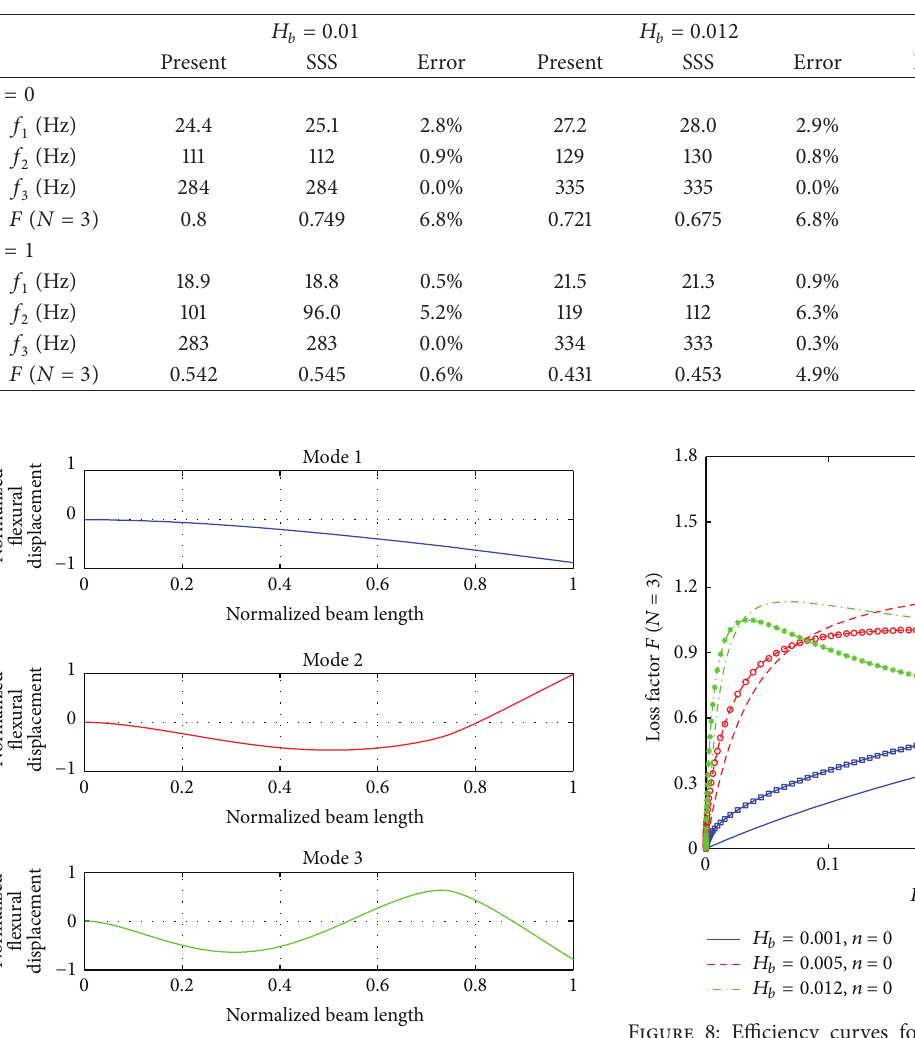
Figure 7: Mode shapes for full-cover CLD beams.